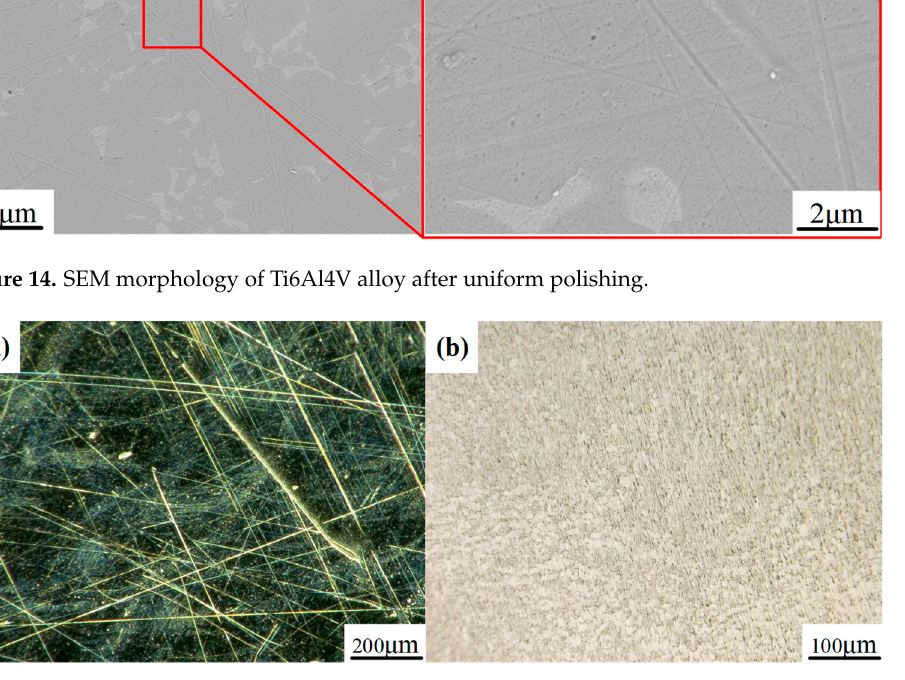
Figure 15. The super depth of field morphology of Ti6Al4V alloy ( a ) before and ( b ) after uniform polishing.